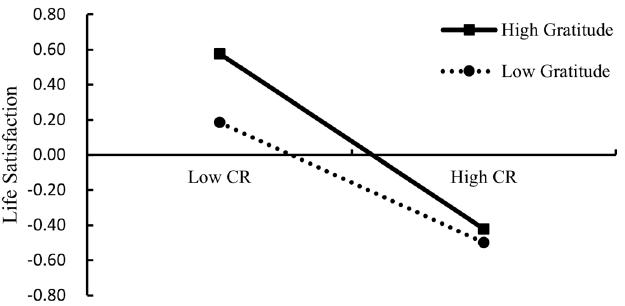
Figure 3. The interaction of CR and gratitude on life satisfaction. Note: CR = cumulative risk.